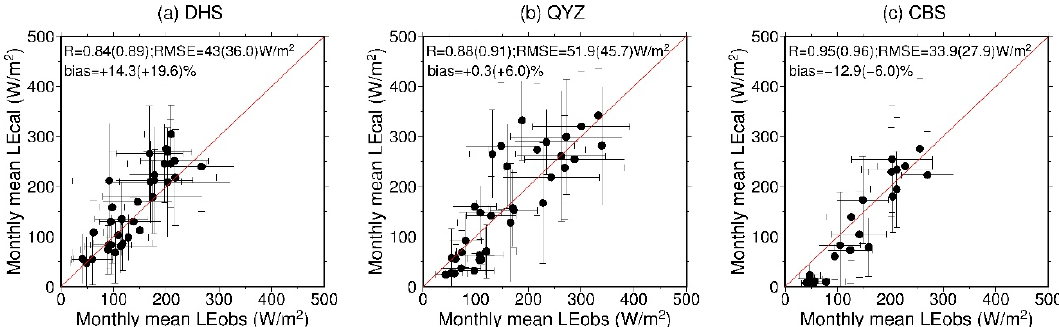
Figure 9. Comparisons between monthly mean LE obs and LE cal at DHS, QYZ, and CBS. Horizontal and vertical error bars stand for the standard deviations of LE obs and LE cal . Numbers in the brackets are the statistic results after removing the heavily rain-contaminated samples.